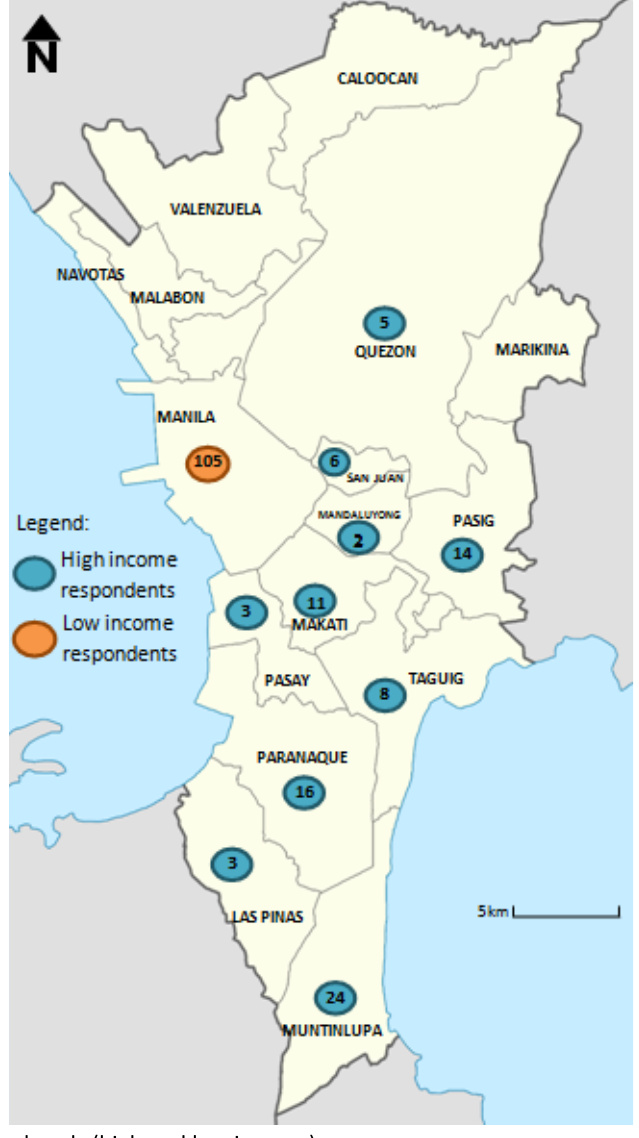
Figure 2. Case study neighbourhoods (high and low